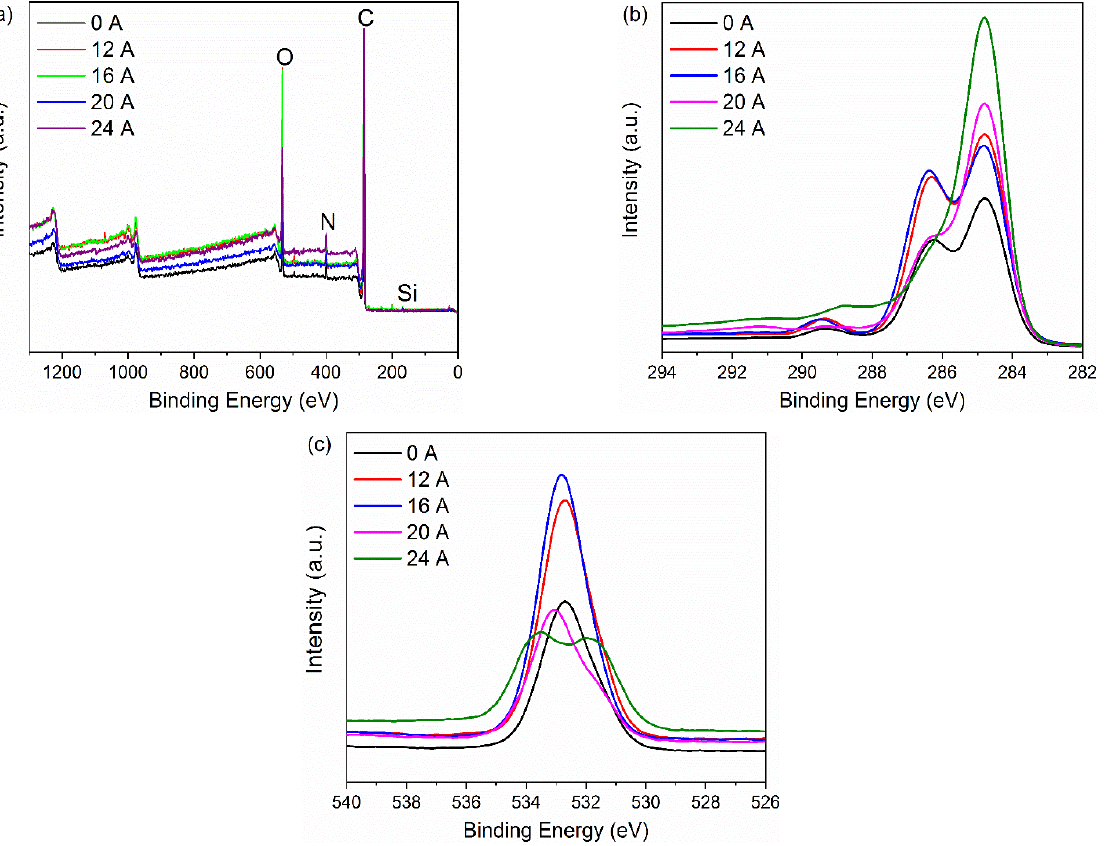
Figure 3. XPS spectra of the samples treated with different current intensities: ( a ) full XPS spectra, ( b ) the C 1s spectra, ( c ) the O 1s spectra. Table 1. Analysis of chemical elements on the CF surface.